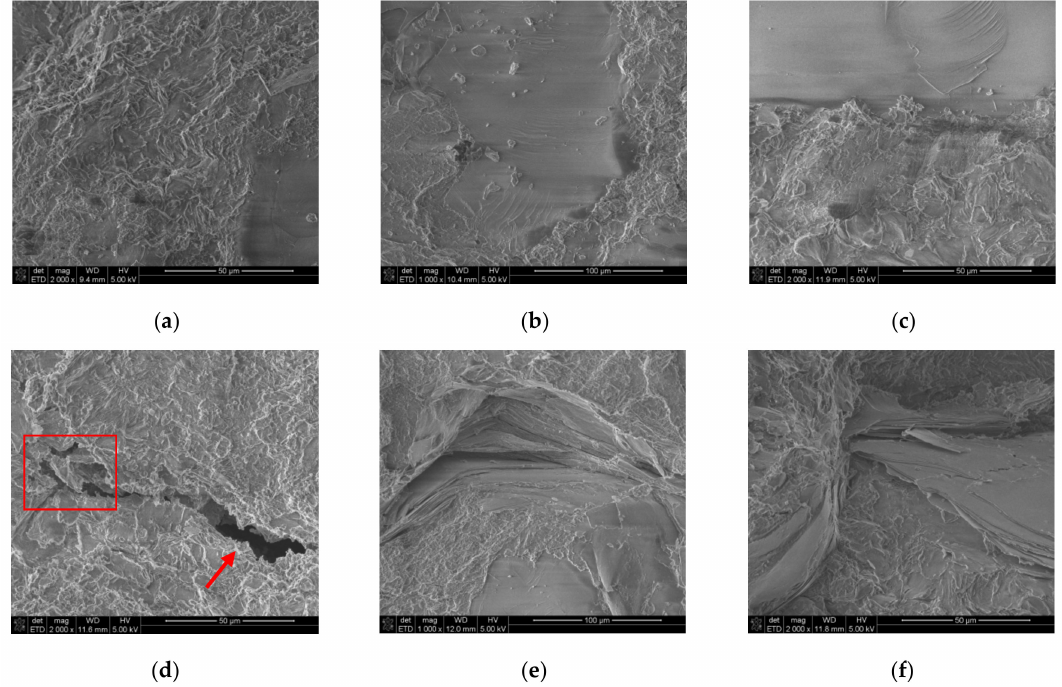
Figure 9. SEM fractography of fractures in sandstone (the red box indicates fragmentation, and the arrow indicates a pore. ( a ) BD fracture (20 ◦ C); ( b ) BD fracture (300 ◦ C); ( c ) SCB fracture (300 ◦ C); ( d ) SCB fracture (600 ◦ C); ( e ) SCB fracture (600 ◦ C); ( f ) BD fracture (600 ◦